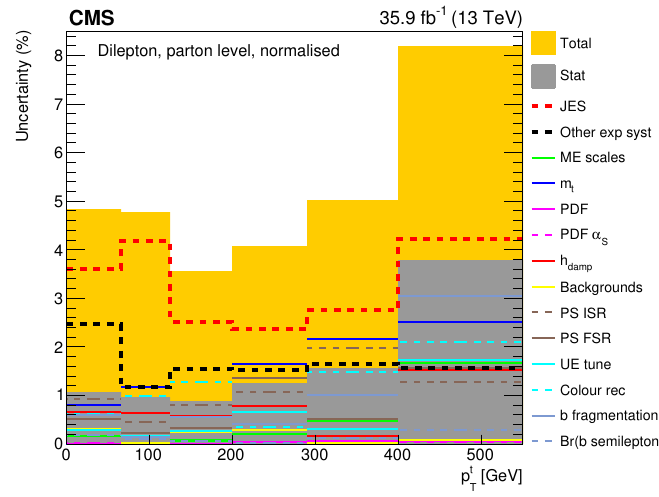
Figure 5 . The contributions of each source of systematic uncertainty in each bin is shown for the measurement of the normalised tt production cross sections as a function of p t ing the JES are added in quadrature and shown as a single component. Additional experimental systematic uncertainties are also added in quadrature and shown as a single component. Contribu- tions from theoretical uncertainties are shown separately. The statistical and total uncertainties, corresponding to the quadrature addition of statistical and systematic uncertainties, are shown by the dark and light (cid:12)lled histograms, respectively.